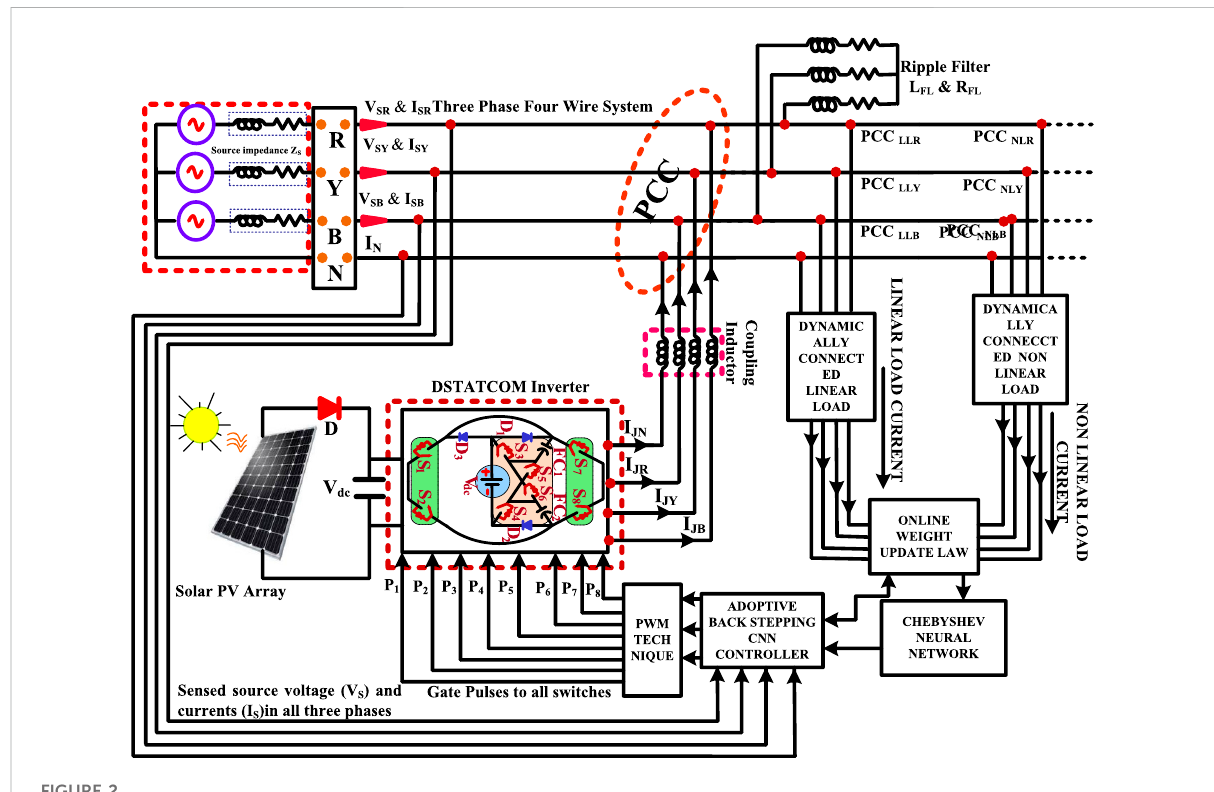
FIGURE 2 Proposed inverter topology with the overall structure of the three-phase four-wire system of the DSTATCOM application.